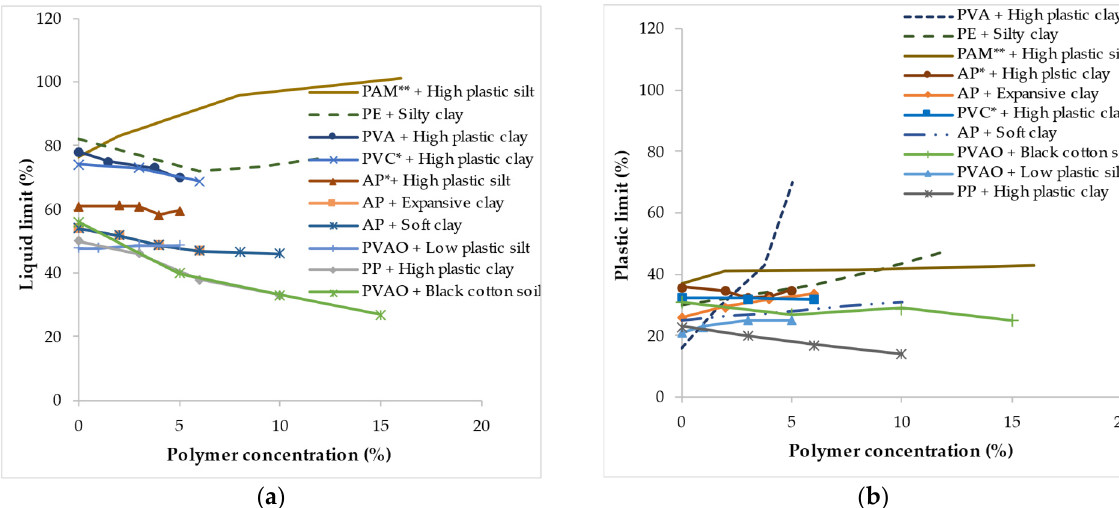
Figure 1. Variation in the Atterberg limit resulting from polymer inclusion at high concentra- tion: ( a ) Liquid limit; ( b ) Plastic limit (* indicates polymer concentration as a % of dry weight of soil and ** as a % of weight of water). Note: these figures were created with data obtained from